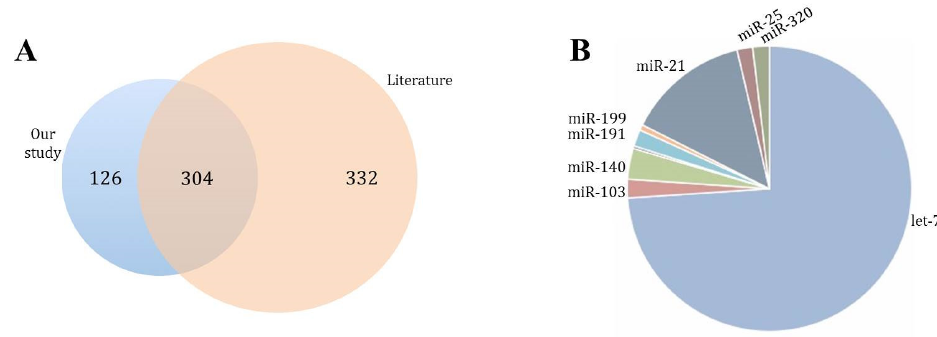
Figure 3. Bibliographic characterization of identified miRNAs. ( A ) Precursor-miRNA found in our study (blue circle) compared to literature (orange circle). ( B ) Most representative miRNA families found in our study.